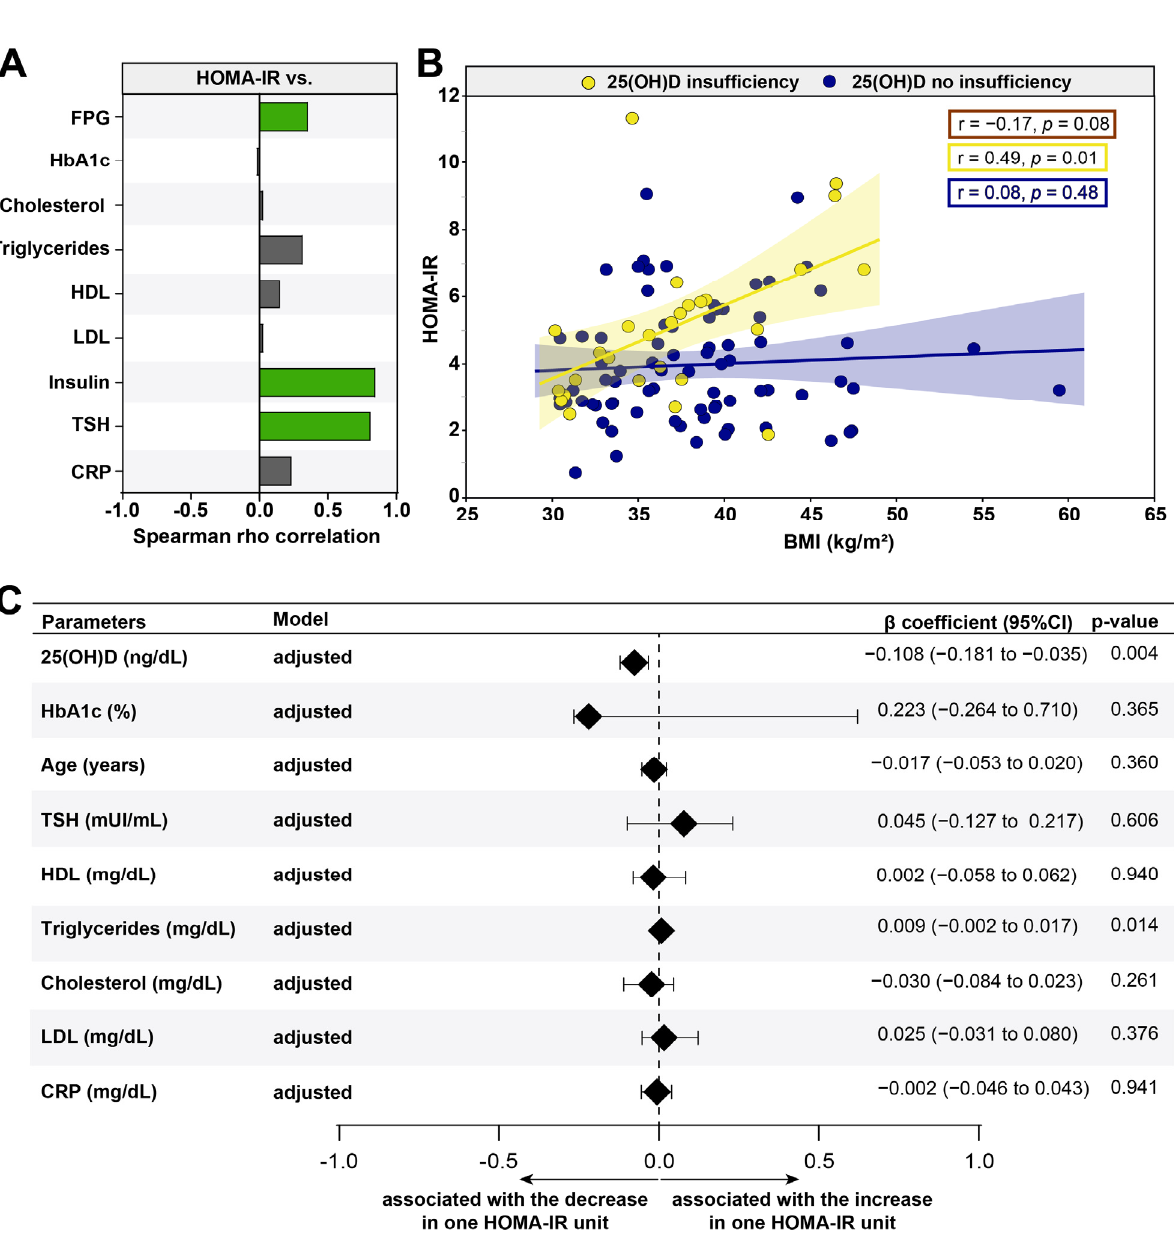
Figure 3. Factors associated with HOMA-IR among women with obesity. ( A ) Spearman rho correlation between HOMA-IR and clinical and biochemical parameters; statistically significant differences are highlighted in green (positive) and yellow (negative). ( B ) Spearman correlation between HOMA-IR and BMI levels in women with obesity grouped according to 25-hydroxyvitamin D status; the values of r and p shown in the figure correspond to the general population (red box), with insufficient VID D (yellow box) and without insufficient VITD (blue box). ( C ) A linear regression analysis was used to test independent association between clinical and biochemical parameters and HOMA-IR. Abbreviations: FPG = Fasting plasma glucose; HbA1c = Glycated hemoglobin; HDL: High ‐ density Lipoprotein; LDL = Low ‐ density Lipoproteins; TSH = Thyroid ‐ stimulating hormone; CRP = C ‐ reactive protein; 25(OH)D = 25 ‐ hydroxyvitamin D.